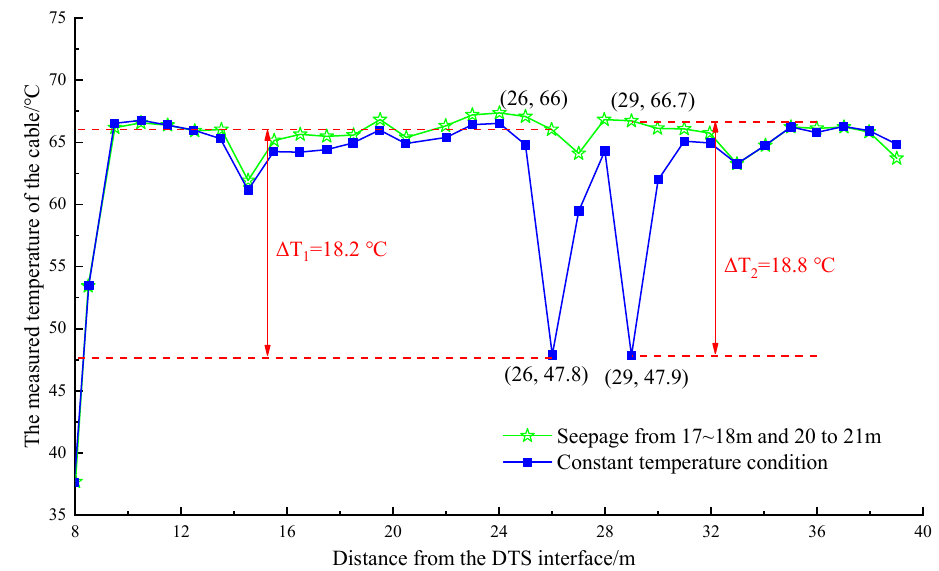
Figure 15. Temperature drop curve at the position of 17~18 m, 20~21 m in the pipeline.